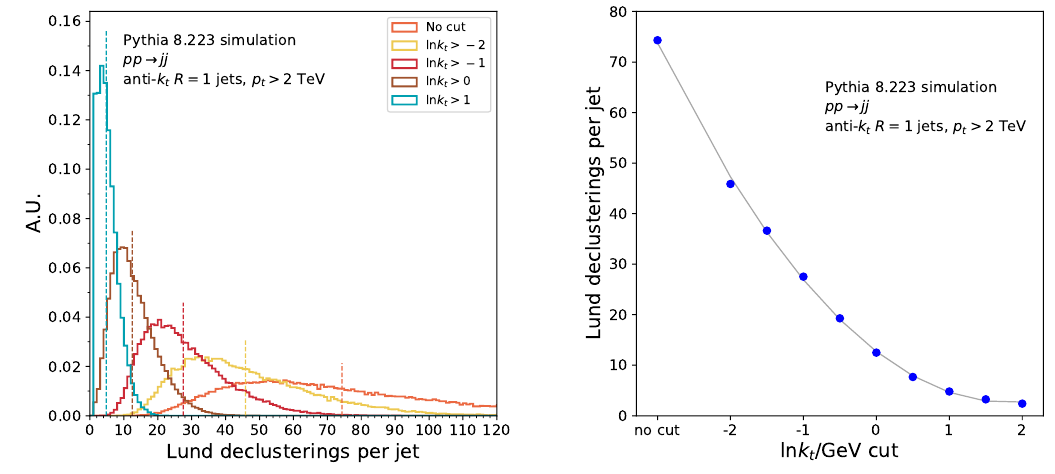
Figure 2 . Left: distribution of the number of Lund declusterings per jet, for different choices of k t cuts in the Lund plane. The dashed lines indicate the mean of each distribution. Right: average of the number of nodes per jet as a function of the k t